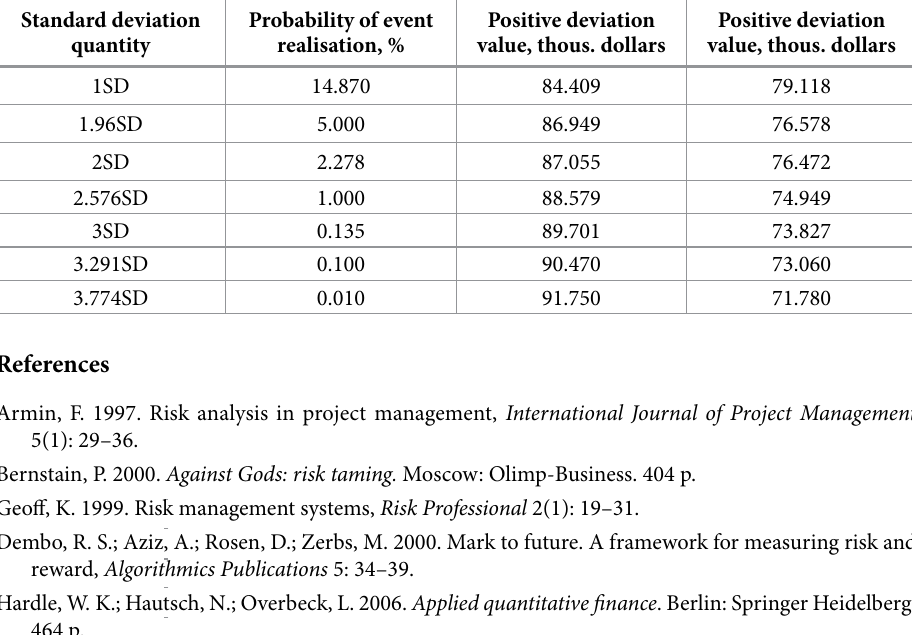
Appendix 1. Table of probability values for occurrence of event P versus mathematical expectation and standard deviation (is used for constructing the statistical distribution curve) Standard deviation